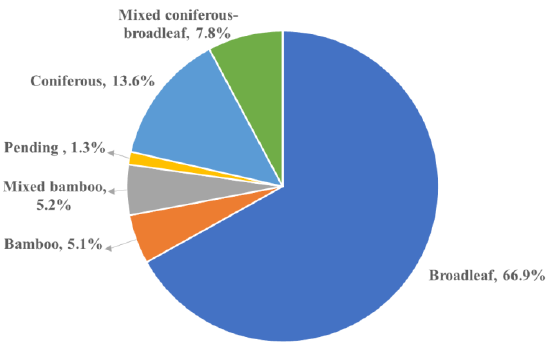
Figure 1. Forest types and their percentages based on the total forest area in Taiwan [11]. The total forest stock volume is estimated at 502.0 million cubic meters, calculated by area of forest type and its stock volume per hectare on average. Table 2 lists the forest types and their stock volumes [11], showing that stock volume and percentage in natural forests accounts for 429.5 million cubic meters (including 103.1 million cubic meters in coniferous forests, 268.9 million cubic meters in broadleaf forests and 57.6 million cubic meters in mixed coniferous–broadleaf forests) and 85.6%, respectively. By contrast, the stock volume and percentage in artificial forests (forest plantation) occupied 64.5 million cubic meters (including 29.5 million cubic meters in coniferous forests, 19.8 million cubic meters in broadleaf forests and 15.2 million cubic meters in the mixed coniferous–broadleaf forests) and 12.8%, respectively. The remaining belongs to mixed bamboo forests, which only share 8.0 million cubic meters and 1.6%, respectively. Furthermore, the total carbon storage (as carbon dioxide) can be obtained by using the IPCC method [3], showing an estimated value of about 754.2 million metric tons. In terms of forest type, the carbon storages (percentages) are summarized below: